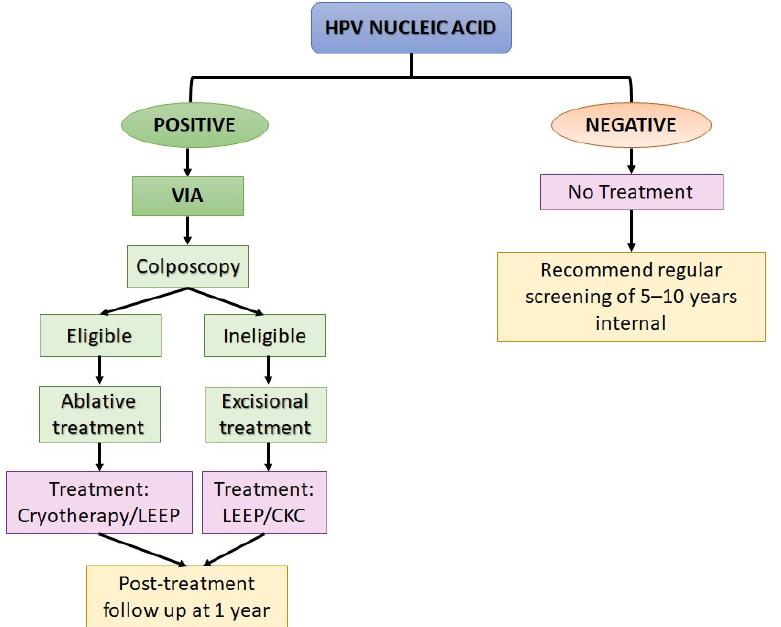
Figure 3. A summary of screen-and-treat strategies recommended by the World Health Organization (WHO) for screening and treatment of precancerous lesions for cervical cancer prevention [103]. LEEP, Loop electrosurgical excision procedure; CKC, cold knife conization.